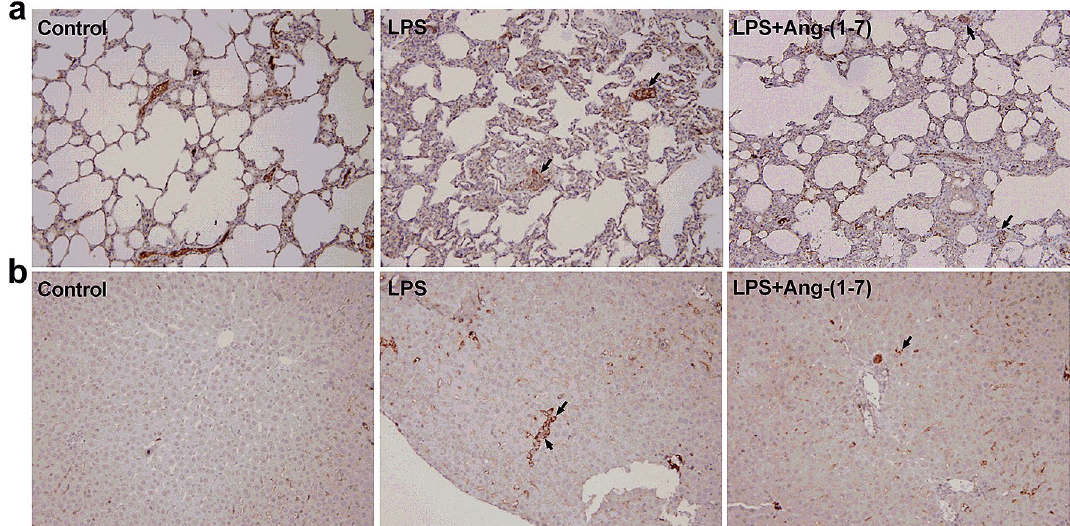
Figure 9. Effect of Ang-(1–7) on NF-κB p65 activation in lung and liver tissues in endotoxaemic rats. Immunohistochemistry staining for phosphorylated- NF-κB p65 in lung ( a ) and liver ( b ) tissues in rats infused with 0.9% NaCl (control), E. coli lipopolysaccharide (LPS, 10 mg/kg for 15 min), or LPS plus Ang-(1–7) (1 mg/ kg for 3 h at 0.5 h after LPS, LPS + Ang-(1–7)). Arrows indicate positive staining. Samples were obtained at 6 h after LPS. Shown are representative photographs from 3 independent experiments in which the same results were obtained. Magnification ×